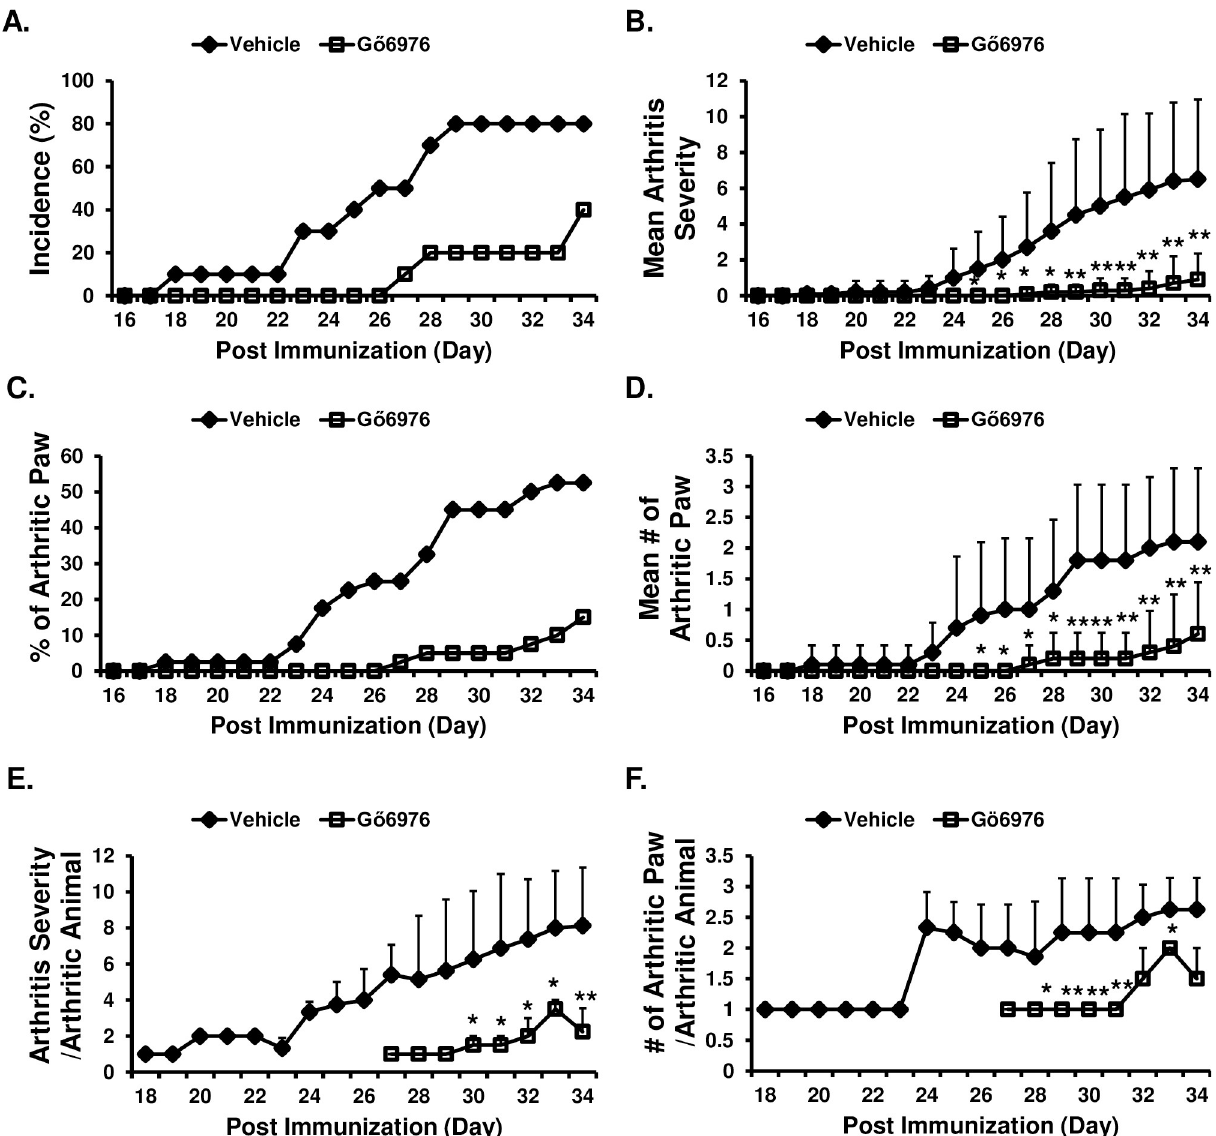
Fig 2. Effects of Go¨6976 on the development and progression of CIA. HLA-DR1 mice were immunized with bovine CII and treated daily with vehicle (n = 10) or Go¨6976 (n = 10) for 34 days starting at the day of CII immunization. Mice were observed daily and development of arthritis was assessed. (A) Incidence of arthritis. (B) Mean arthritis severity. Data represent the mean ± SD. � , p < 0.05; �� , p < 0.005. (C) The % of arthritic paws. (D) Mean number of arthritic paws in a mouse. Data represent the mean ± SD. � , p < 0.05; �� , p < 0.005. (E) Arthritis severity score in an arthritic mouse. Data represent the mean ± SD. � , p < 0.05; �� , p < 0.005. (F) Number of arthritic paws in an arthritic mouse. Data represent the mean ± SD. � , p < 0.05; �� , p < 0.005. Experiments were repeated four times with similar